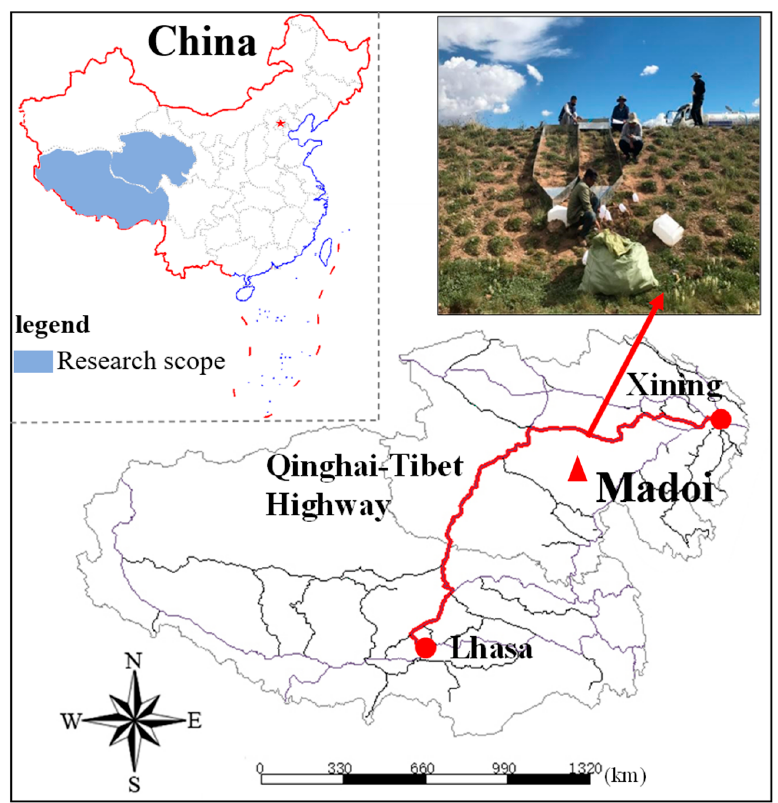
Figure 3. Location of experimental region.